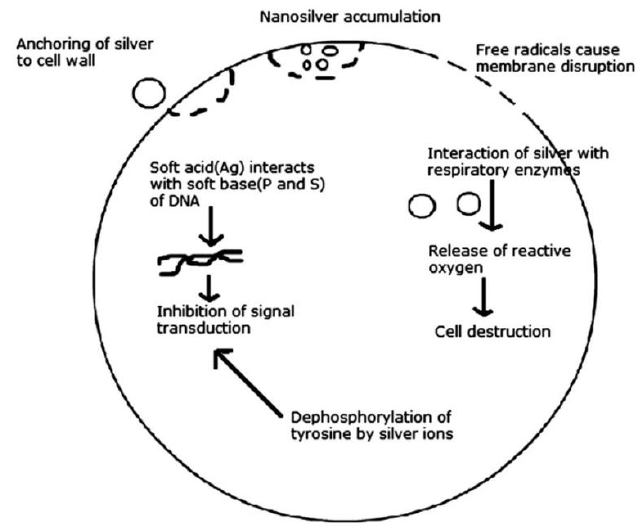
Figure 1. Various modes of action of silver nanoparticles (AgNPs) on bacteria [57].